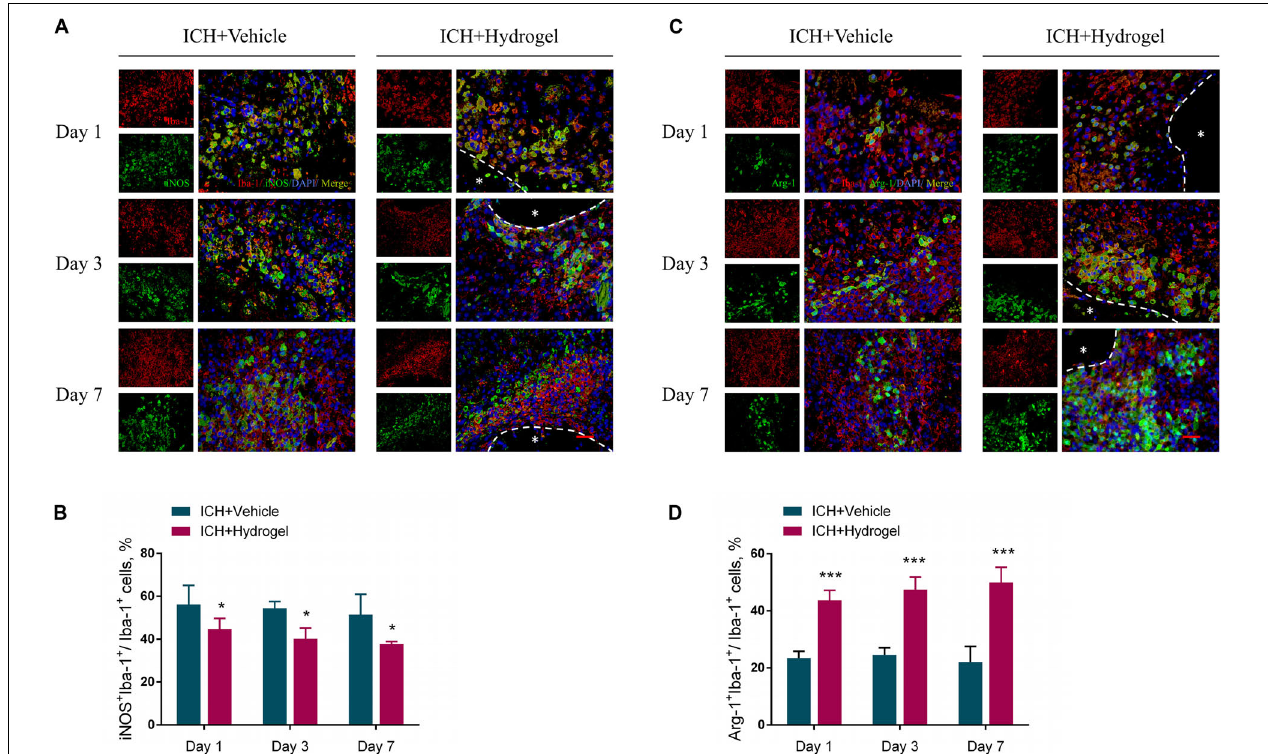
FIGURE 6 | Effects of gelatin hydrogel on microglia/macrophages polarization. (A) M1 pro-inflammatory microglia/macrophages marker iNOS + Iba-1 + . (B) The percentage of iNOS + Iba-1 + cells/Iba-1 + cells in two groups. (C) M2 anti-inflammatory microglia/macrophages marker Arg-1 + Iba-1 + . (D) The percentage of Arg-1 + Iba-1 + cells/Iba-1 + cells in two groups. Scale bar = 20 µ m. Data are mean ± SD, n = 4 mice per group, * P < 0.05, *** P <